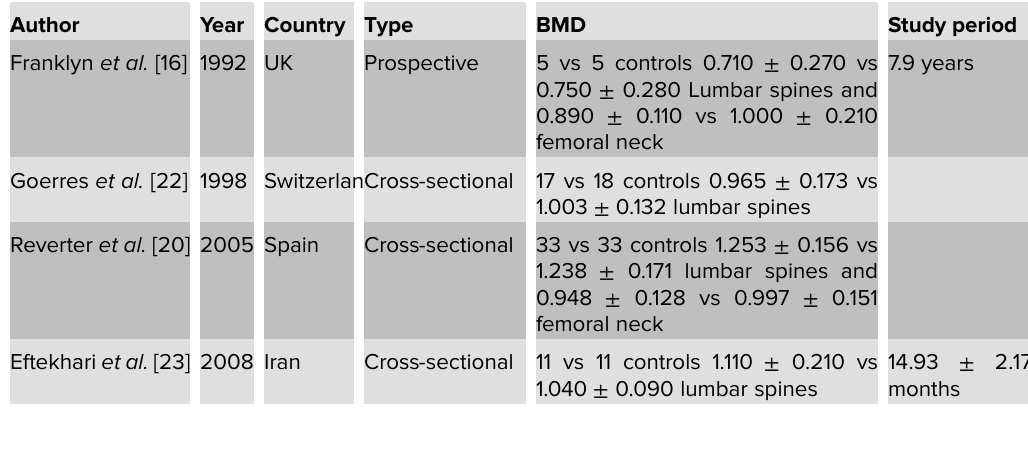
Table 4: TSH suppression for differentiated thyroid carcinoma and bone mineral density among men.